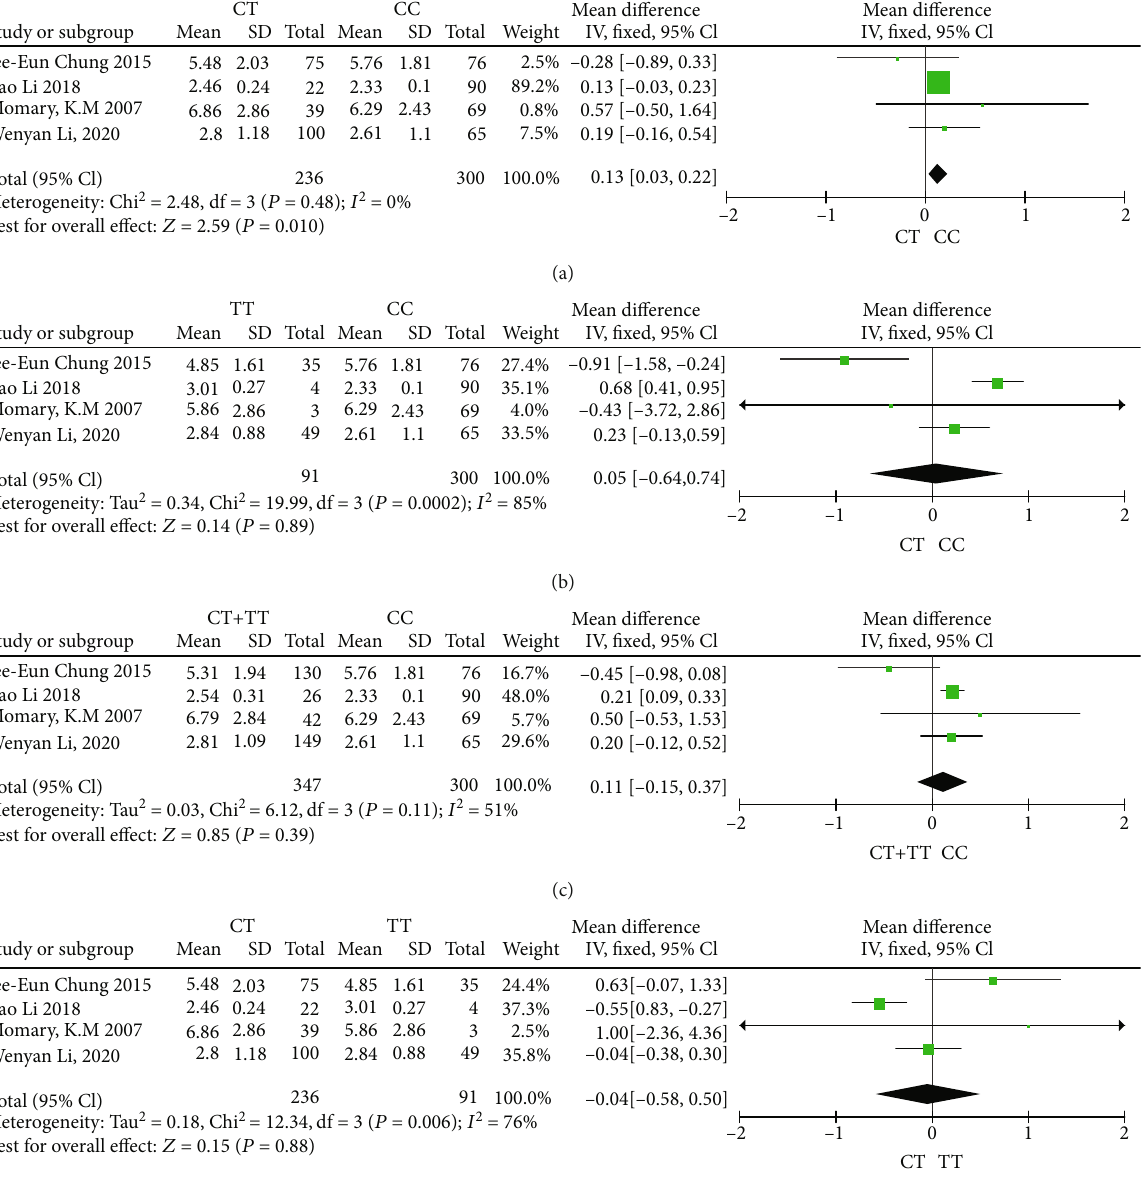
Figure 2: Forest plots illustrating the in fl uence of NQO1 rs1800566 polymorphisms on warfarin dose requirement. (a) Relative warfarin dosage requirement of rs1800566 CT carriers compared to CC carriers (wild-type). (b) Relative warfarin dosage requirement of rs1800566 TT carriers versus CC carriers. (c) Relative warfarin dosage requirement of rs1800566 T carriers (CT or TT carriers) versus CC carriers. (d) Relative warfarin dosage requirement of rs1800566 CT carriers versus TT carriers. Mean (SD): mean and standard deviation of normalized warfarin doses associated with each genotype. IV: inverse variance; CI: con fi dence interval. Values in the square brackets denote 95% con fi dence